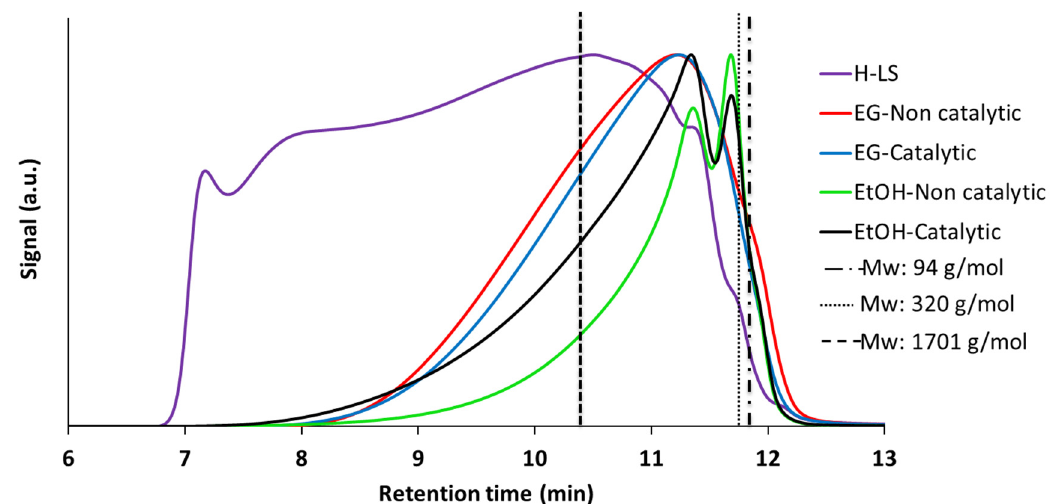
Figure 3. SEC of H-LS and the non-catalytic and catalytic oil products from conversion of H-LS in Figure 3. SEC of H ‐ LS and the non ‐ catalytic and catalytic oil products from conversion of H ‐ LS in EtOH and EG media. Reaction condition: 0/0.75 g Ni/SiO 2 catalyst, 7.5 g H-LS, 75 mL solvent, initial EtOH and EG media. Reaction condition: 0/0.75 g Ni/SiO 2 catalyst, 7.5 g H ‐ LS, 75 mL solvent, initial H 2 loading of 50 bar at RT, reaction temperature of 250 ◦ C, 3 h reaction H 2 loading of 50 bar at RT, reaction temperature of 250 °C, 3 h reaction time.